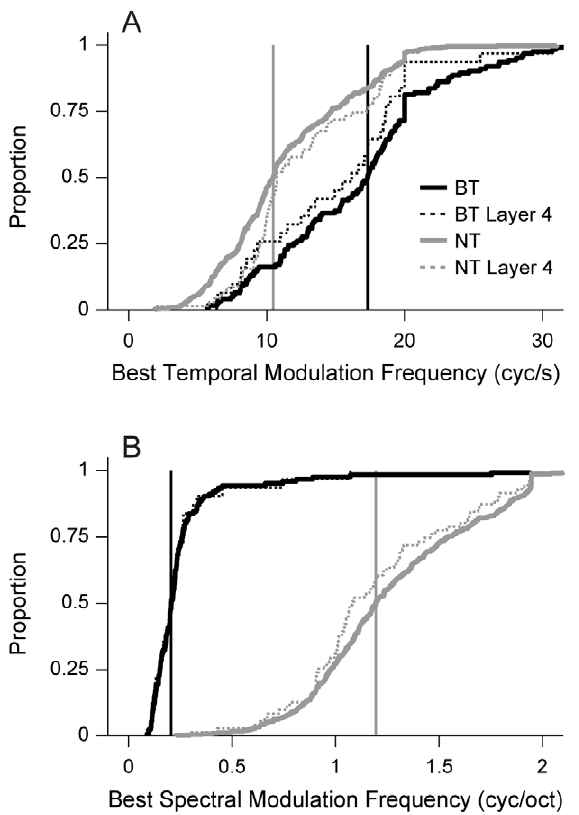
Figure 8. Best modulation frequencies of BT and NT AI neurons. (A) Distribution of best temporal modulation frequencies (bTMFs). Solid lines represent population data. Vertical lines indicate population medians. Dashed lines represent values for neurons in layer 4 (800–1100 m m). BT neurons had higher bTMFs (p , 0.001, KS-test). BT neurons have significantly higher bTMFs. (B) Distribution of best spectral modulation frequencies (bSMFs). NT neurons had higher bSMFs (p , 0.001,